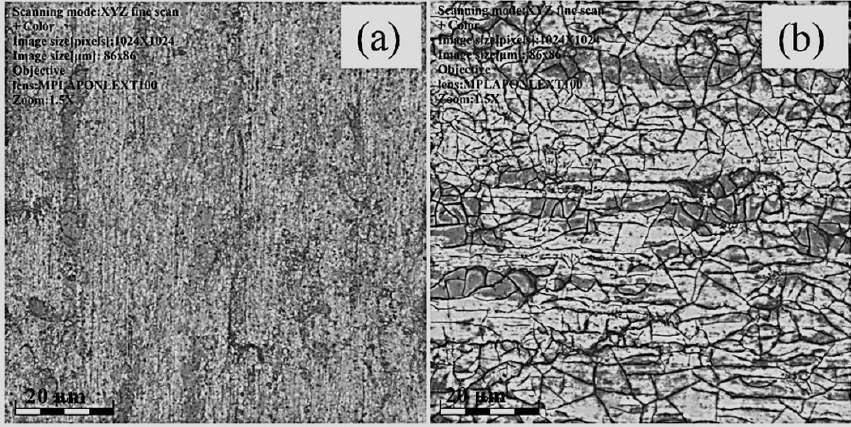
Figure 9. Photographs of the surface of coatings: ( а ) τ = 3 min, ( b) τ = 8 min (H 2 TiF 6 : 2 g/L; Ni(NO 3 ) 2 : 0.4 g/L; (NH 4 ) 6 Mo 7 O 24 : 0.3 g/L; рН : 4.6–5.0; T : 20 ° С ).